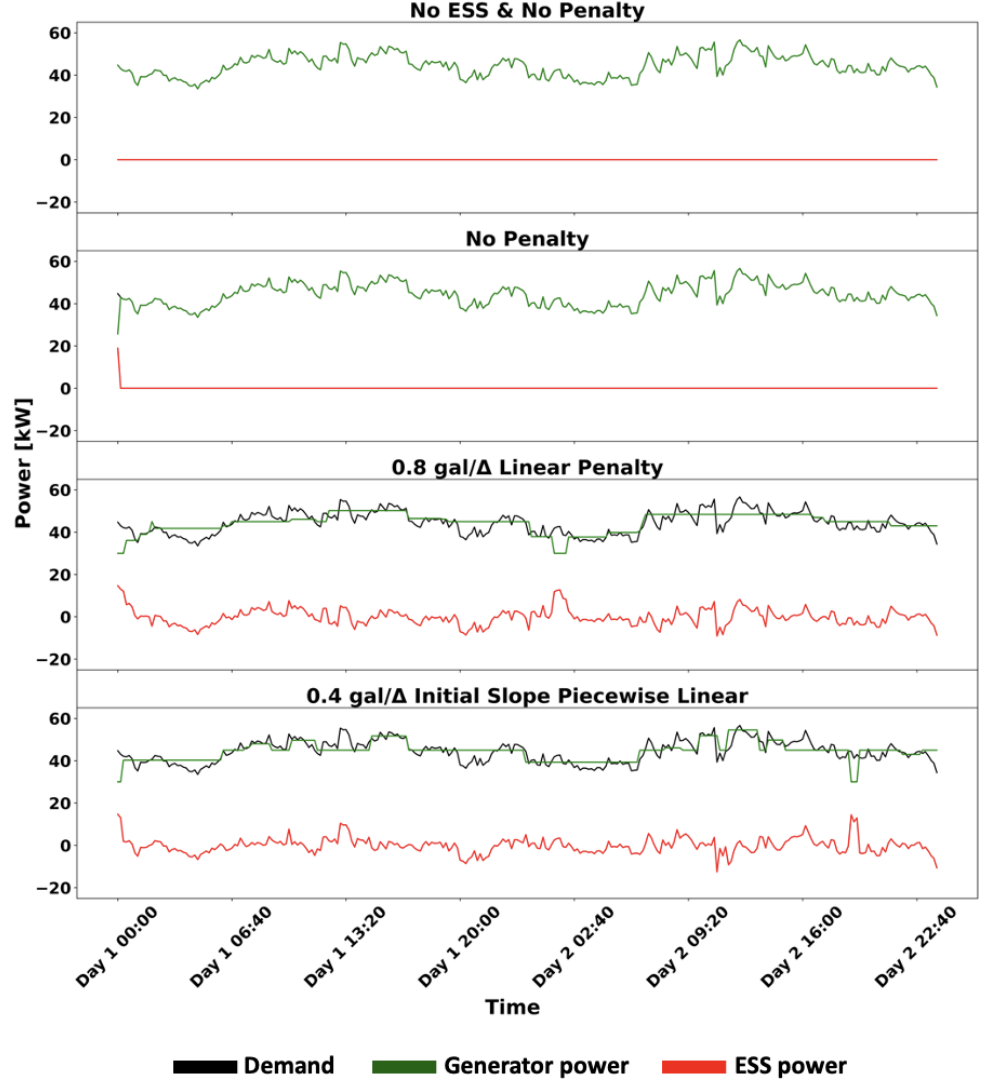
Figure 11. Optimal power distribution over various architectures for the summer demand